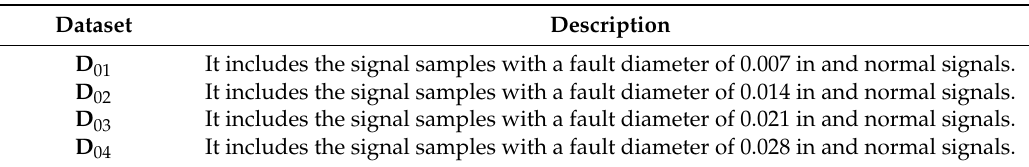
Table 2. The new datasets in group B.